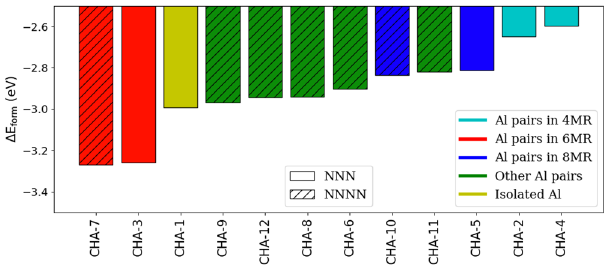
Fig. 3 Formation Energy of Pd + H + on CHA. Each bar represents unique Al location(s). The color coding refers to the type of Al pairs or isolated Al in the zeolite matrix. Solid bars refer to Al pairs in an NNN con fi guration or the isolated site and striped bars refer to the NNNN con fi guration.